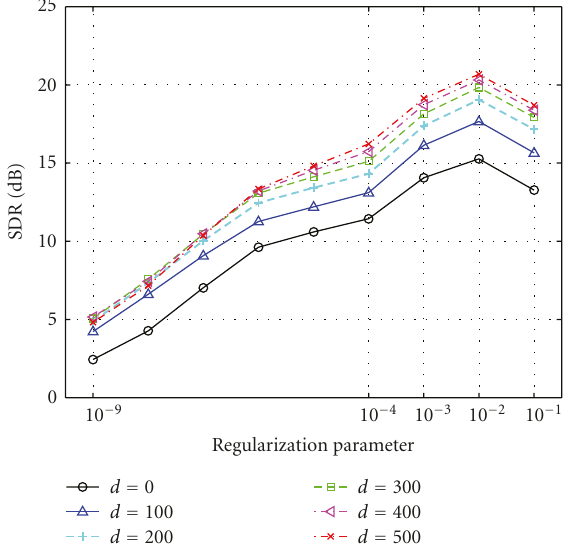
Figure 4: Filter energy as a function of regularization parameter and modeling delay (filter length is fixed at M = 1333).